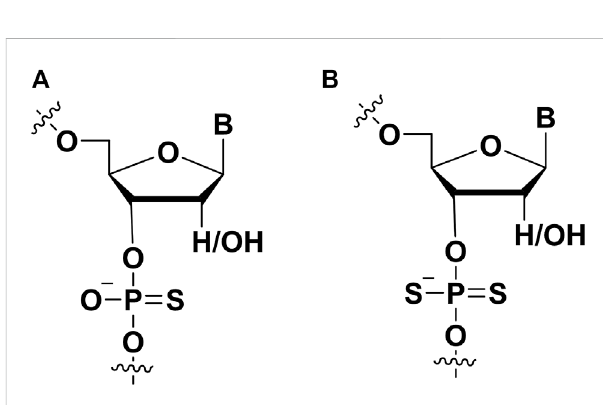
FIGURE 6 The chemical modi fi cations on the phosphate of aptamers